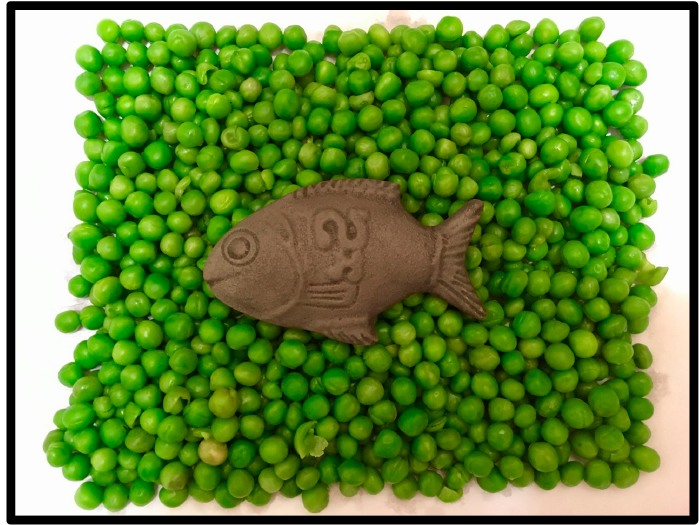
Figure 1. Iron ingot (Lucky Iron Fish™ (LIF)) used to treat iron deficiency. The selected picture background shows the relative size of LIF compared to petit pois peas